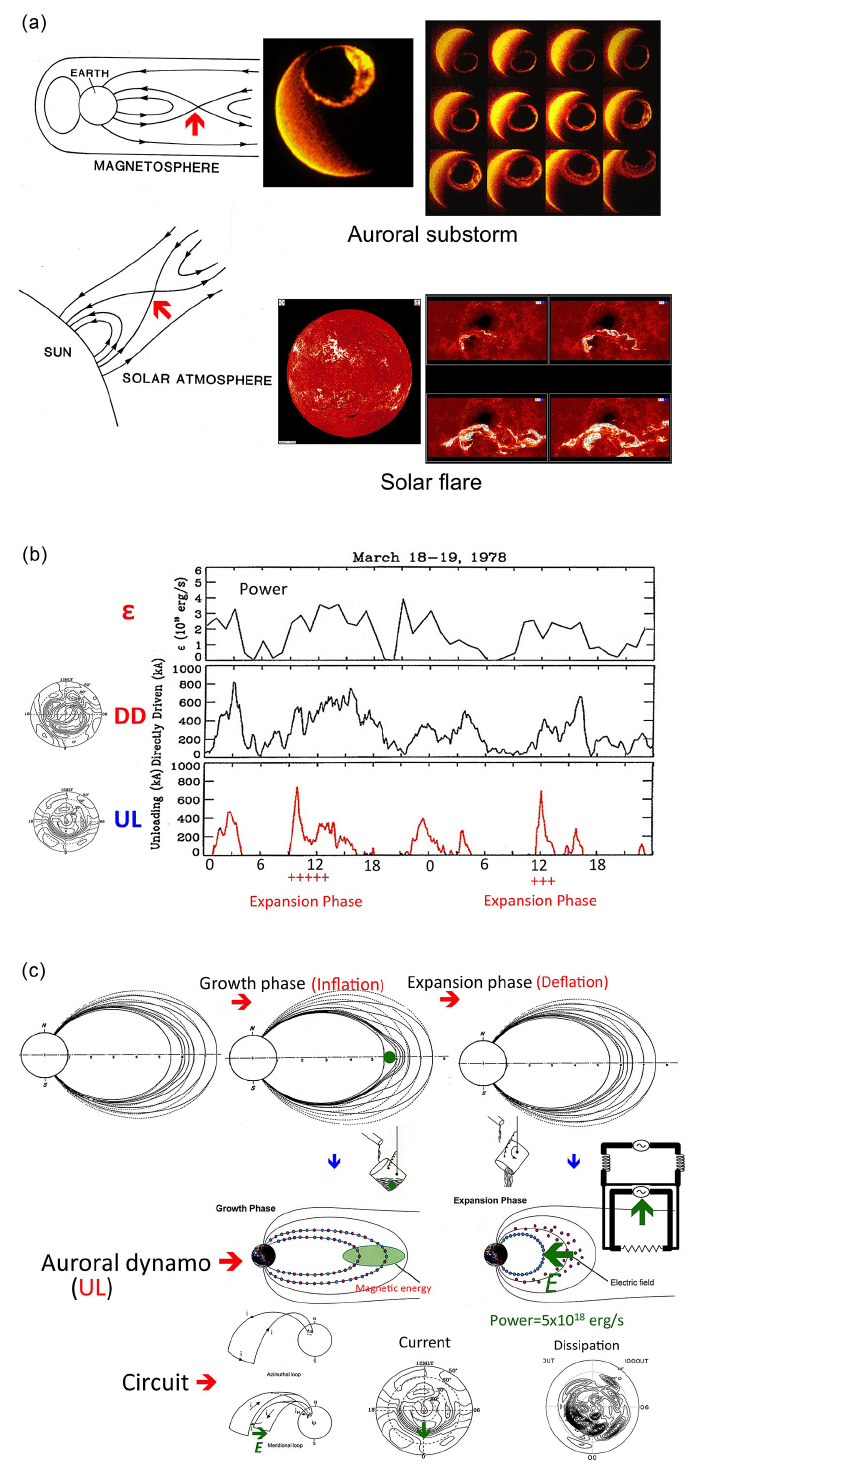
Figure 9. (a) Images of auroral substorms and solar flares, as well as their time sequences. Both the magnetotail and the cusp configuration are also schematically shown. (b) shows from the top, the solar-wind–magnetosphere dynamo power ε (t), the directly driven (DD) component of the ionospheric (equivalent) current and the unloading component (UL). The figure shows that there occurs no prominent current other than DD and UL (or dissipation), indicating that magnetic re-connection does not produce any prominent extra energy (or dissipation). (c) The figure illustrates how the charge separation might occur when the inflated magnetosphere is deflated; electrons are tied to contracting field lines, while protons remain, because of the breakdown of the frozen-in field